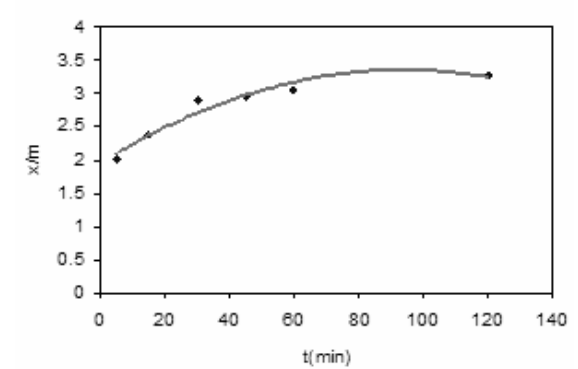
Figure 6. The effect of agitation time in sorption of Hg 2+ ion by